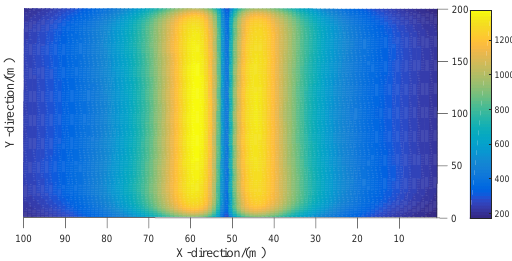
Figure 8. The 3D calculation method results of charge simulation method (CSM).